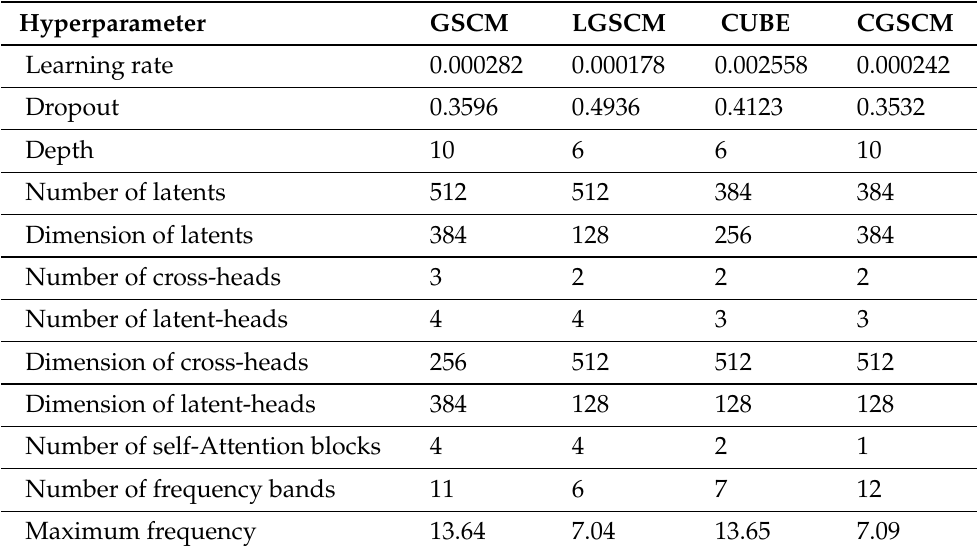
Table 5. Hyperparameters obtained using Optuna [35] for the Perceiver networks of each encoding. The LAMB [38] optimizer was used here.